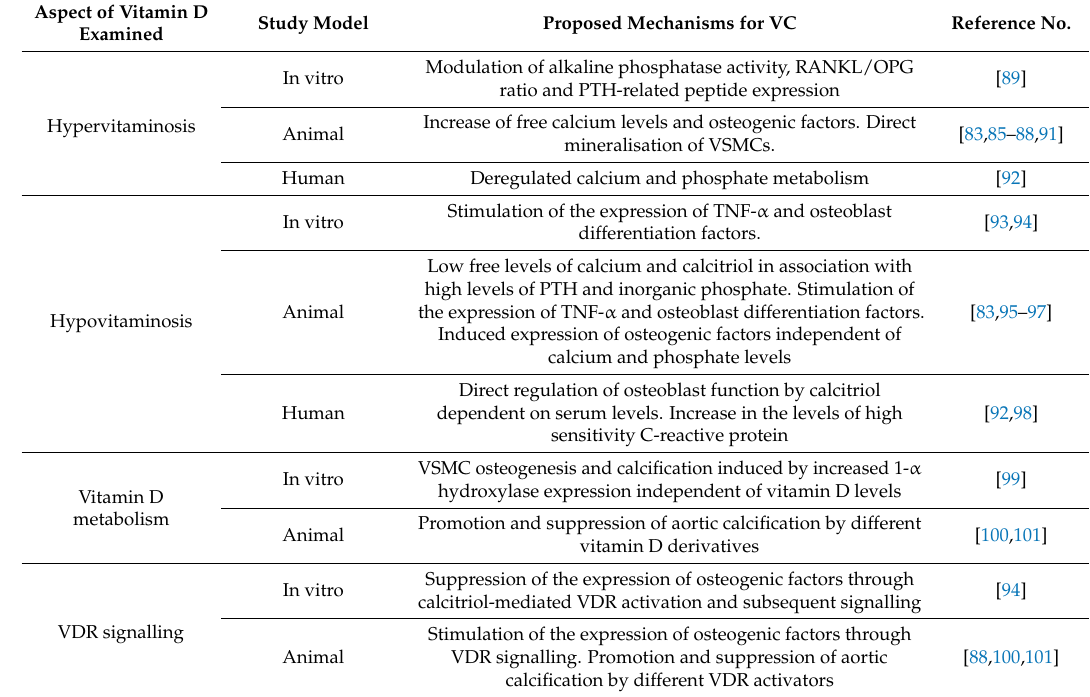
Table 1. Published studies on the impact of vitamin D on vascular calcification